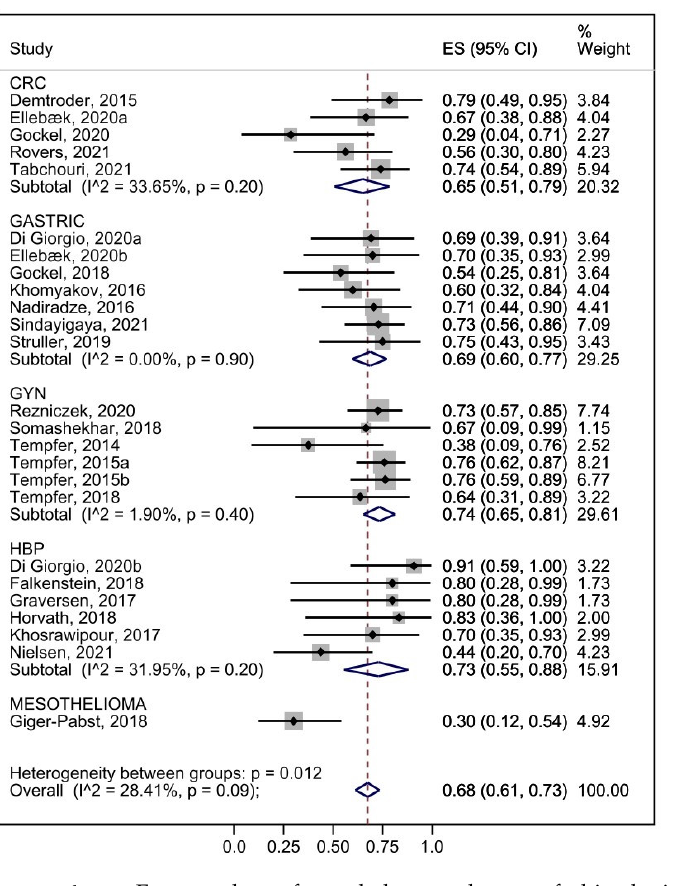
Figure 4. Forest plot of pooled prevalence of histological response stratified by tumor origin [10–12,14,16,17,19,24,27,28,32,33,36,39,43,46–48,50–52,54,57–59].